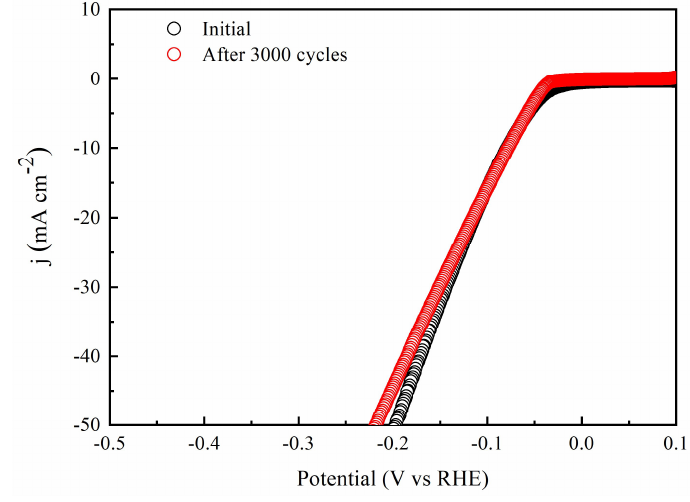
Figure 7. Stability of the 2% Pt-Mo 2 C modified electrode with an initial polarization curve and after 3000 cycles in 0.5 M H 2 SO 4 .